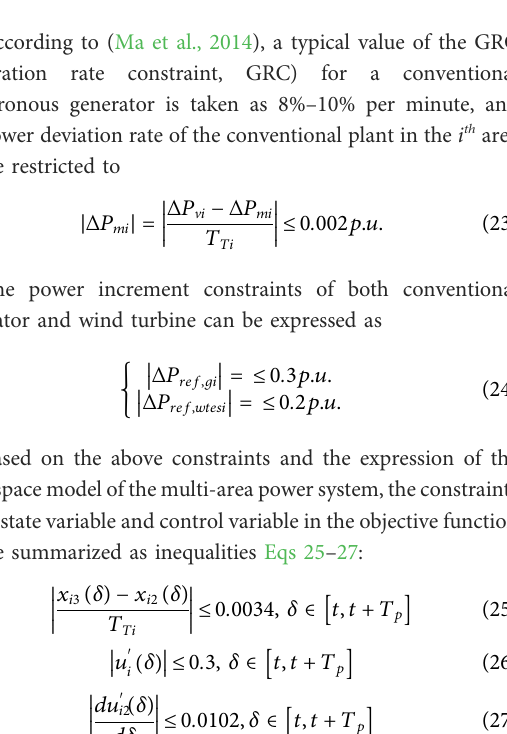
2) Coordinated operation strategy of the CWES system